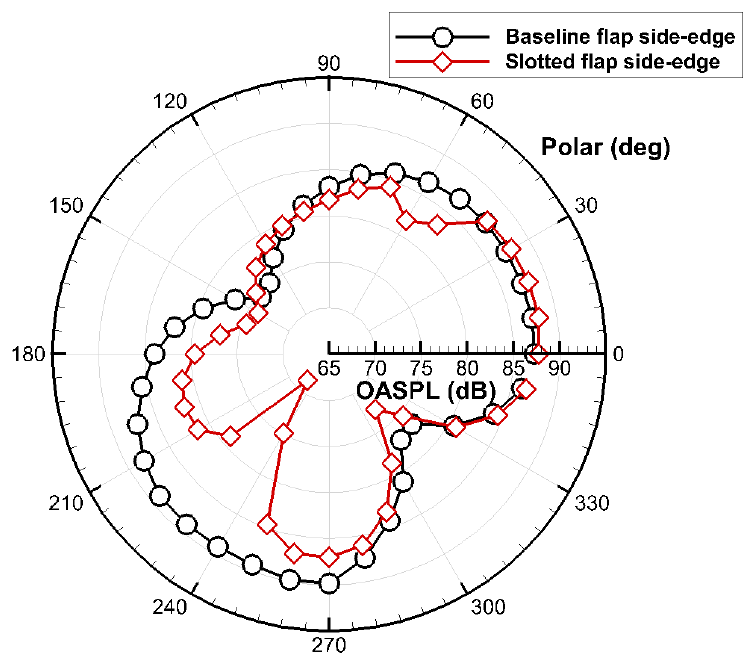
Figure 15. The comparison of the directivity of the flap side-edge noise between the baseline flap side-edge and the slotted flap side-edge.